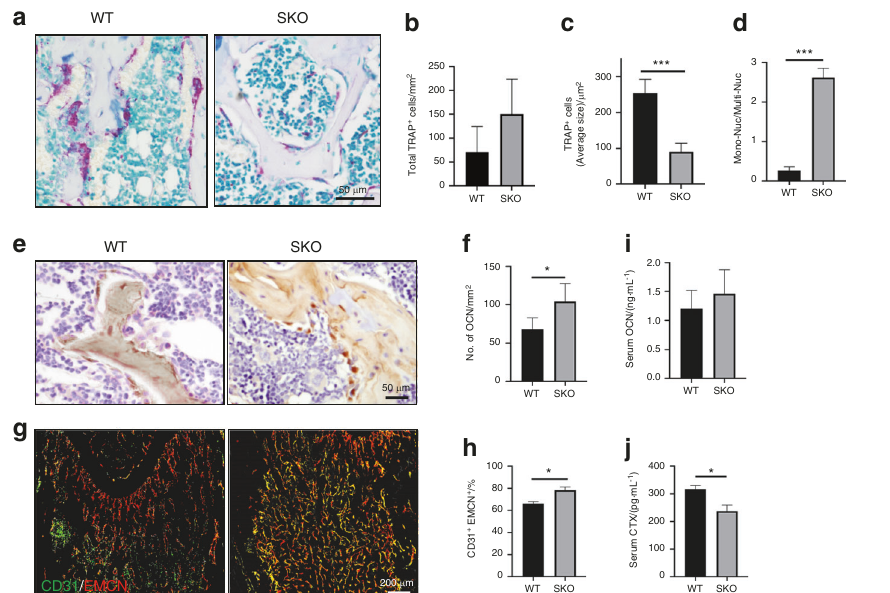
Fig. 2 The numbers of mononuclear TRAP + cells, type H vessels, and osteoblasts were increased in the SKO mice. a Representative images of TRAP staining of the distal femurs of 3-month-old WT and SKO mice. b – d Quantitative analysis of the TRAP staining in a . The number and size of TRAP + cells were normalized to the bone area. Mon-Nuc: mononuclear TRAP + cells, Multi-Nuc: multinuclear TRAP + cells. n = 5, *** P < 0.001. Error bar represents the standard error of the mean. e Representative images of immunohistological staining of osteocalcin in the distal femurs of the 3-month-old WT and SKO mice. f Quantitative analysis of the osteocalcin staining in e . n = 5, * P < 0.05. Error bar represents the standard error of the mean. g Co fl uorescence staining of CD31 (green) and endomucin (EMCN) (red) in mouse femurs. h Quantitative analysis of the ratio of CD31 and EMCN double-positive fl uorescence intensity in g . n = 5, * P < 0.05. Error bar represents the standard error of the mean. ELISAs of OCN ( i ) and CTX ( j ) in the serum of the WT and SKO mice. The mice were sacri fi ced at 3 months of age. n = 5, * P <